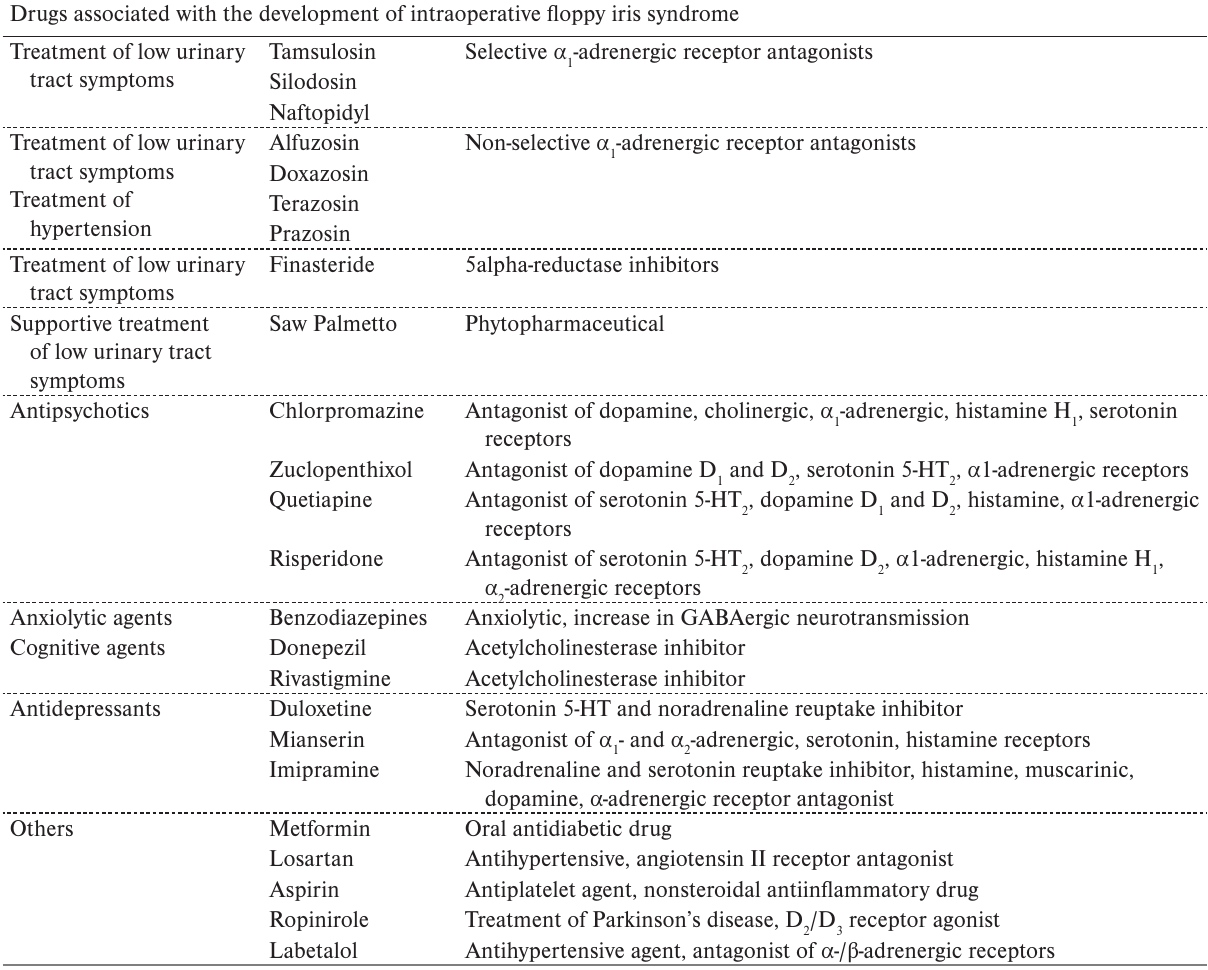
Table 3. Overview of drugs associated with Intraoperative floppy iris syndrome. Drugs associated with the development of intraoperative floppy iris syndrome Treatment of low